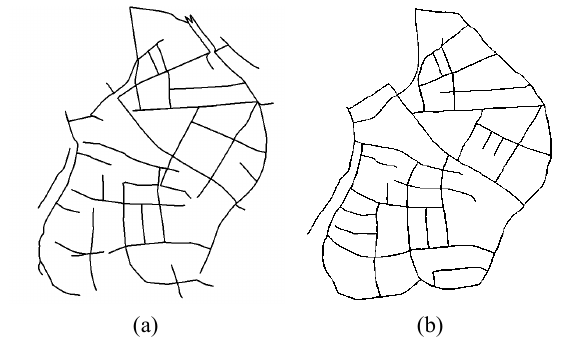
Figure 4. (a) Extracted main road networks, (b) road map reference digitized